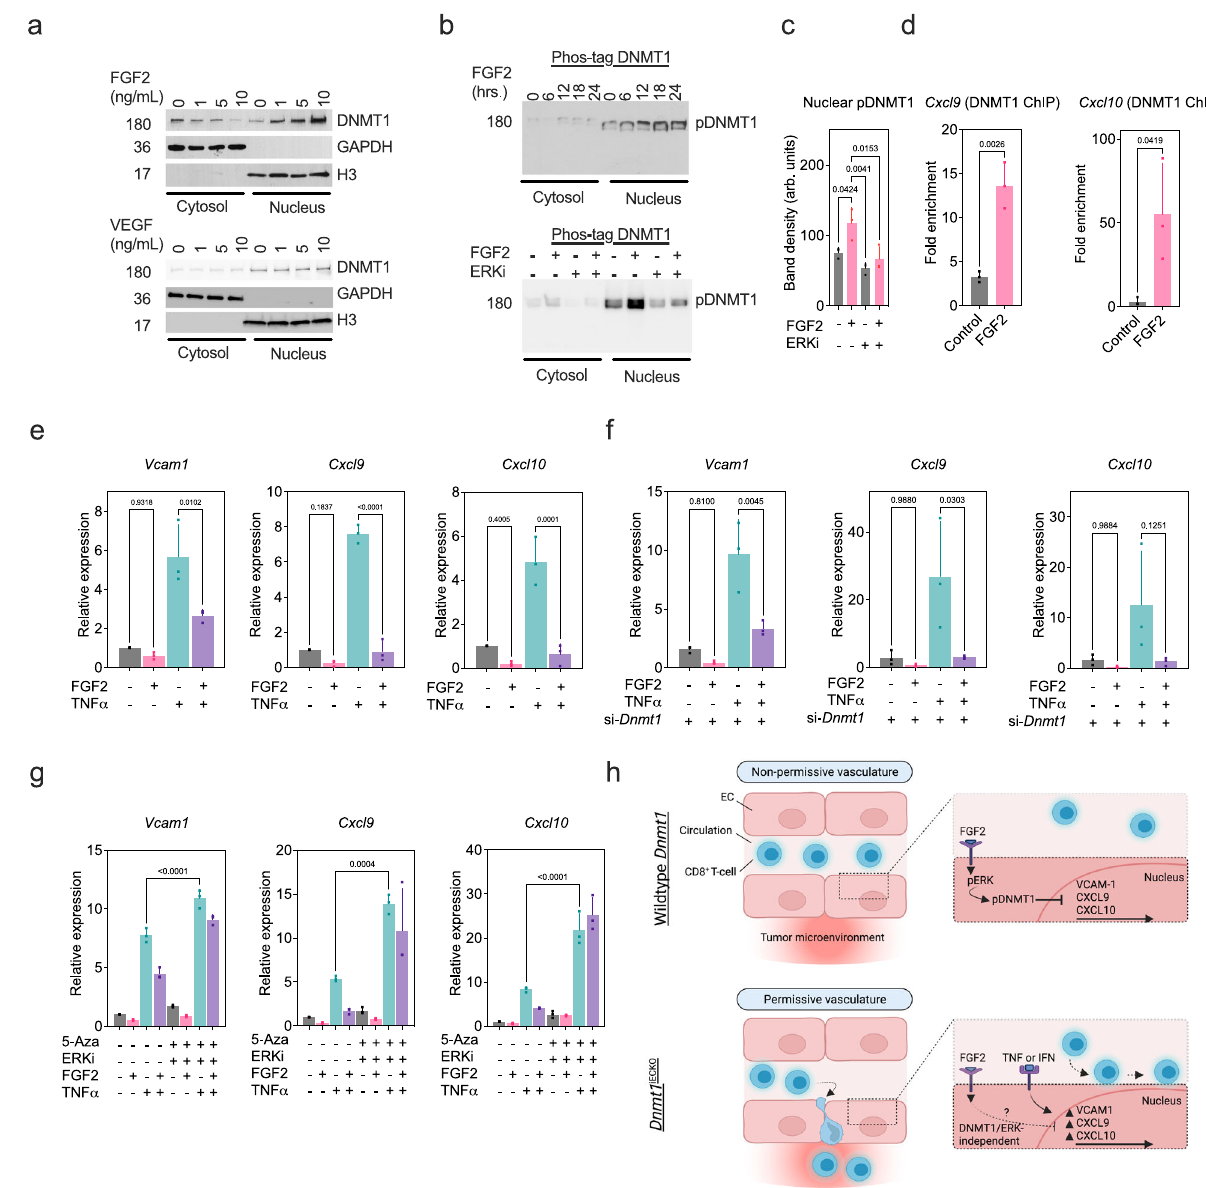
Fig. 7 | ThepotentEC mitogenFGF2 opposes Dnmt1i -mediated potentiationof CAMs and T-cell- attracting chemokines. a MGECs treated with the indicated concentration of FGF2 or VEGF were harvested, split into cytosolic or nuclear fractions,andthenanalyzedfortheindicatedproteinsusingSDS-PAGEfollowedby immunoblotting(representativeof n =3independentblots). b MGECstreatedwith the indicated concentration of FGF2 were harvested, splitinto cytosolic or nuclear fractions, and then analyzed using Phos-tag gel electrophoresis (representative of n =3 independent blots). c Quanti fi cation of nuclear pDNMT1 signal using n = 3 independent gels. Results were analyzed using ANOVA followed by Tukey ’ s multi- ple comparisons test. d ChIP assays in control versus FGF2-stimulated MGECs. ChIPs were performed using cross-linked whole-cell extracts incubated with DNMT1 antibodies. Captured DNMT1/DNA complexes were analyzed by qPCR to assess DNMT1 enrichment on Cxcl9 / Cxcl10 promoters in control versus